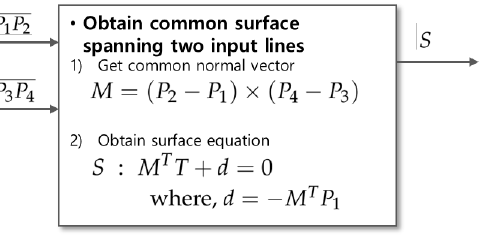
Figure A3. Obtaining a common surface spanning two given lines.